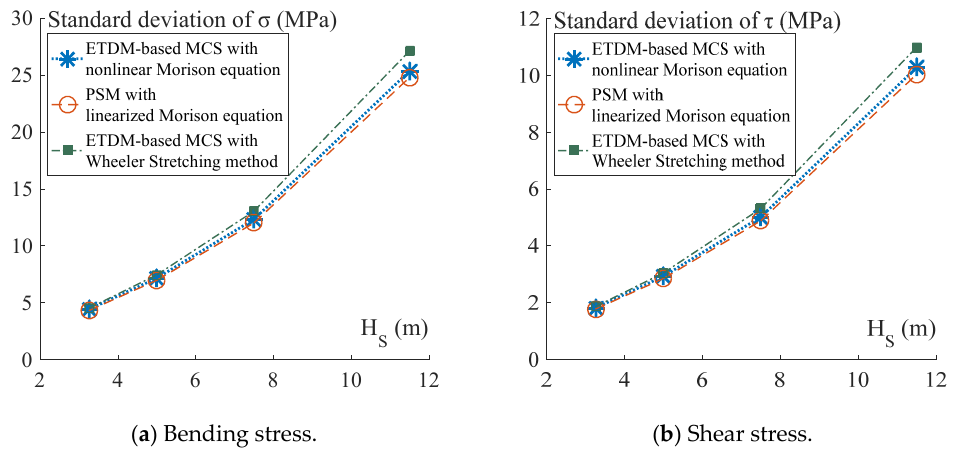
Figure 12. Standard deviations of the bending and shear stress at the bottom of a battered leg of the jacket platform.